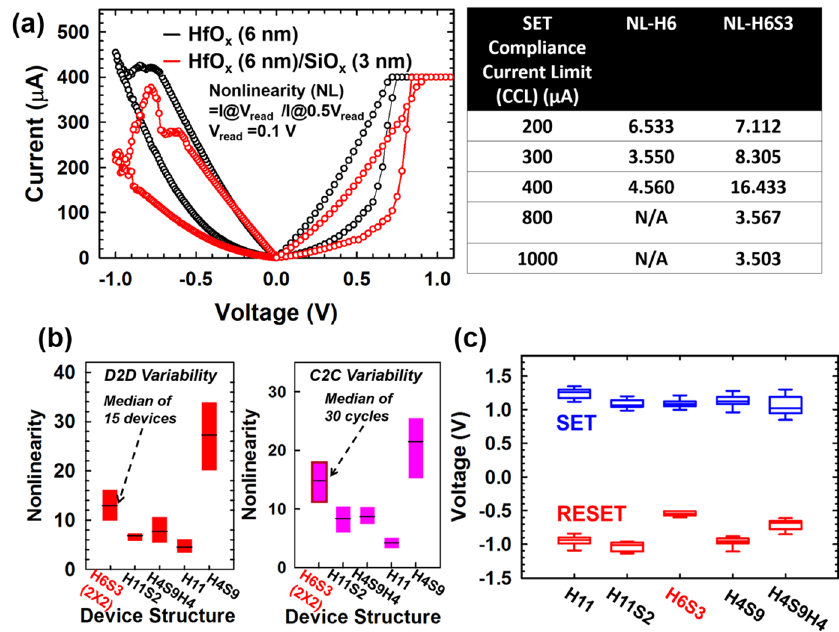
Figure 5. ( a ) I-V characteristics of single-layer and bilayer devices at CCL of 400 µ A (left), and the summarized table of intrinsic nonlinearity under SET CCL modulations, ( b ) Nonlinearity charac- teristics and device-to-device, cycle-to-cycle variability for various stacked structures, ( c ) switching voltages of various stacked structures.